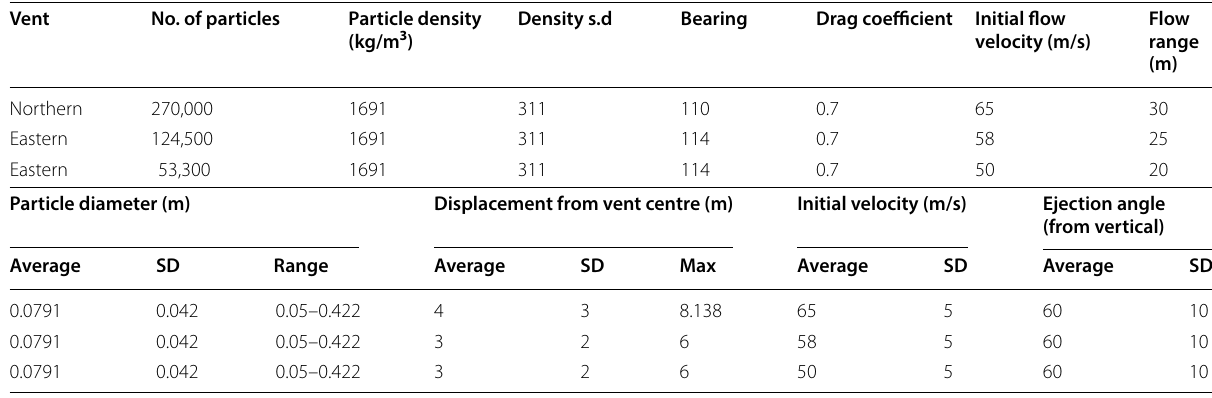
Table 3 Best fit model parameters to the ballistic ejecta determined through over 110 model simulations Vent No. of particles Particle density